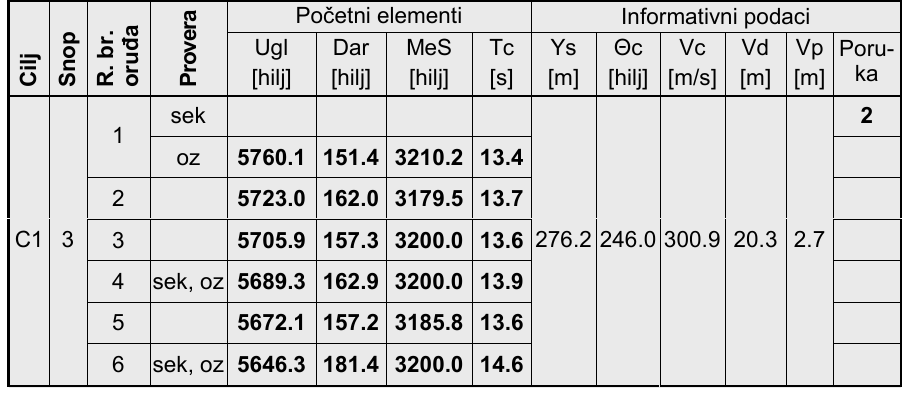
Po č etni elementi Informativni